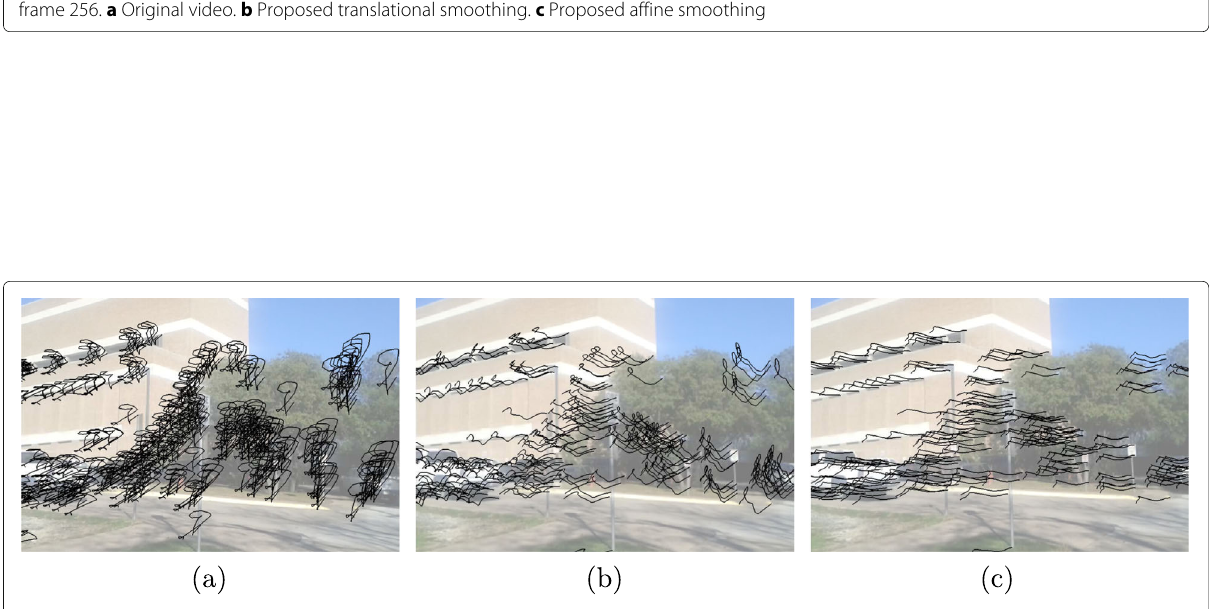
Fig. 12 Stabilization comparison for video 2. Features are tracked from frame 16 to frame 35. The feature tracks are plotted as blackcurves on frame 16. a Original video. b Proposed translational smoothing. c Proposed affine smoothing